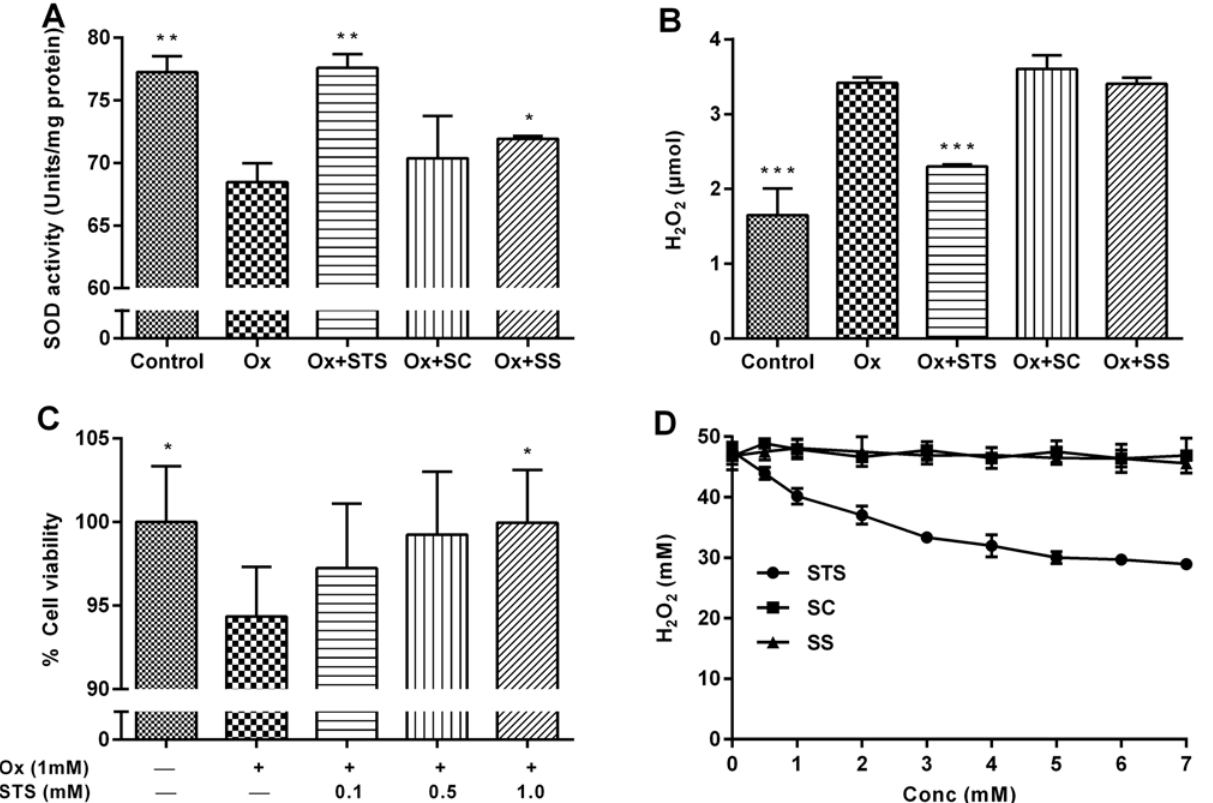
Fig 8. Intra- and extracellular quenching of H 2 O 2 by STS. (A) SOD activity was rescued by STS treatment upon 24 hours of oxalate-exposure to LLC-PK1 cells. (B) Oxalate-exposure of LLC-PK1 cells leads to the intracellular generation and accumulation of H 2 O 2 . While STS-treatment reduced the amount of H 2 O 2 released from the cells after 72 hours, SC- and SS-treatment did not. (C) 72 hours of oxalate-exposure of LLC-PK1 cells leads to a significant decrease in cell viability (measured by sulforhodamine), which was maintained by STS in a dose dependent manner. (D) STS directly quenches H 2 O 2 in aqueous solution, providing evidence for a direct interaction between STS and the non-radical oxidant H 2 O 2 . SC and SS in contrast did not lead to the consumption of H 2 O 2 . The changes and significance levels are with reference to the Ox group. The data are means ± SD from 8 values per group. * p < 0.05, ** p < 0.01, *** p <